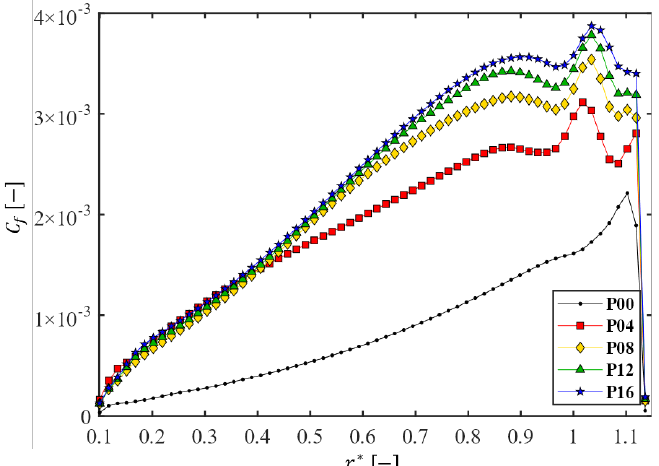
Figure 9. The change of the line-averaged friction coefficient 𝐶 𝑓 at the membrane surface as a function of the dimensionless radius 𝑟 ∗ = 𝑟/𝑅 𝑖 for the five filtration modules with different numbers of patterns on the disk. Here, 𝛺 = 200 rpm.